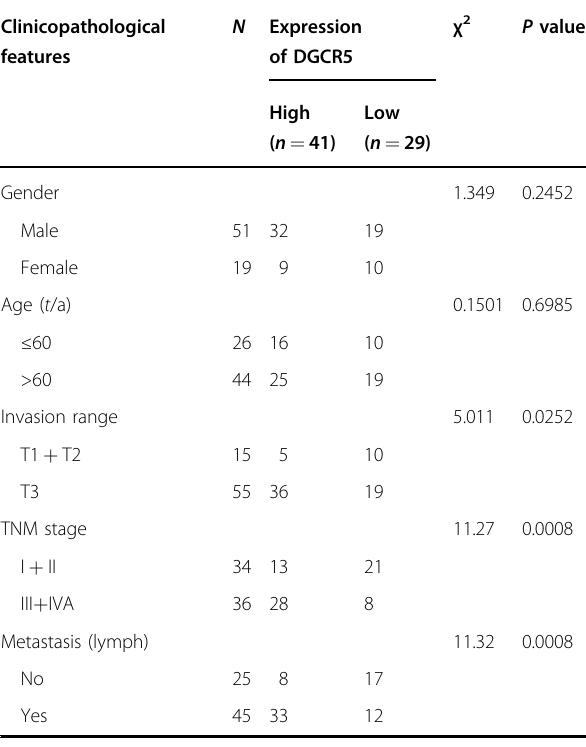
Table 1 The relationship of lncRNA DGCR5 and clinical characteristics in 70 ESCC